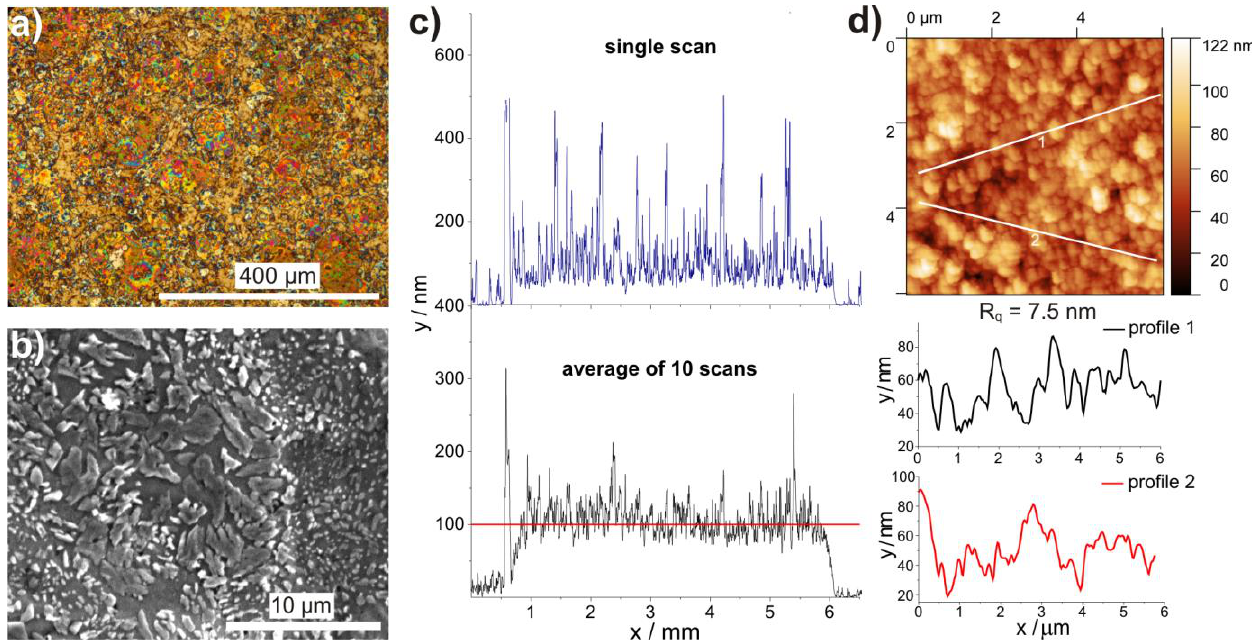
Figure 3. Surface observation of rubrene thin films deposited by MAPLE on Si obtained with 18,000 laser pulses at fluence of 4 J/cm 2 . ( a ) in the optical microscope image, the red and orange spots correspond to presence of rubrene crystalline phase; ( b ) SEM image shows irregularly distributed grains formed on surface of the base layer; ( c ) peaks in the profilometer scans correspond to distribution of crystallites grown from base layer of thickness ~100 nm; ( d ) AFM surface image reveals a structured film with rare discontinuities and presence of sub-micrometric domains.